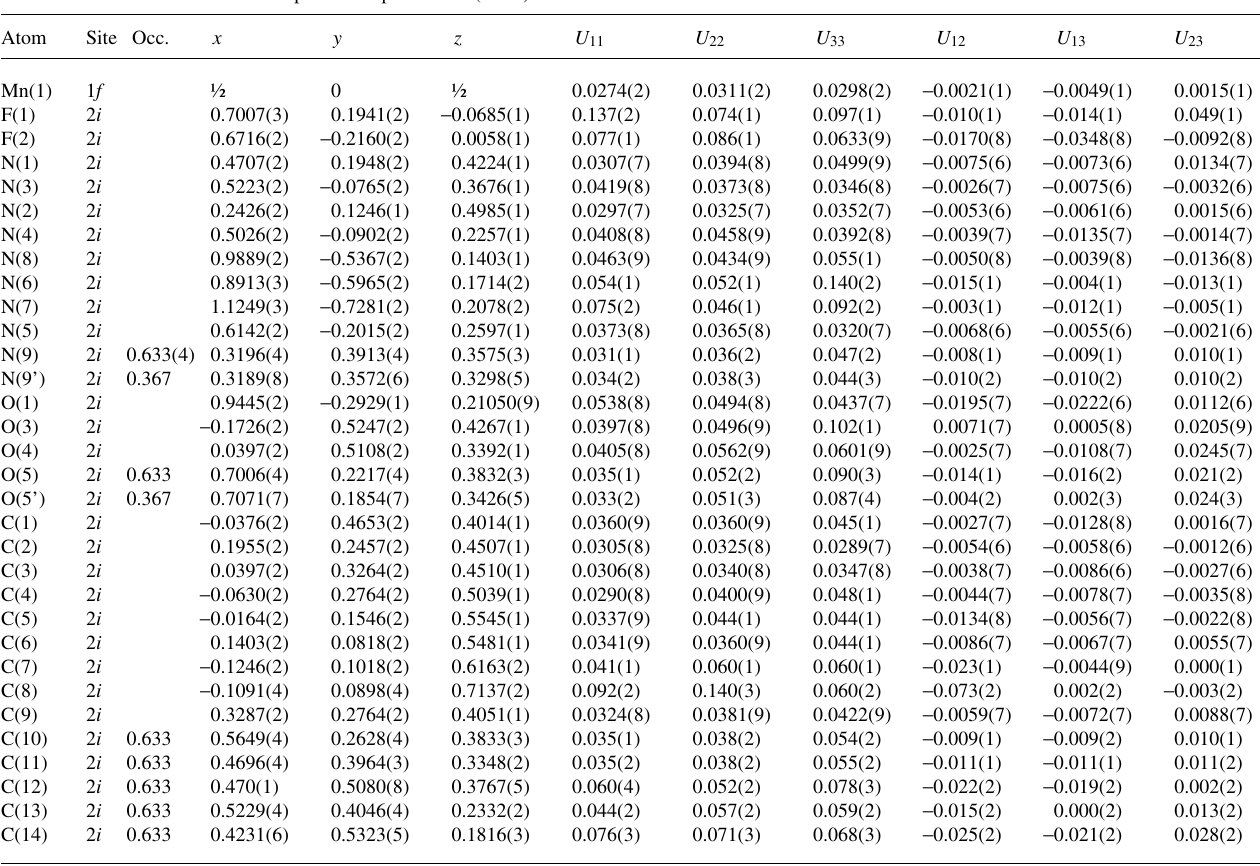
Table 3. Atomic coordinates and displacement parameters (in Å 2 ) .